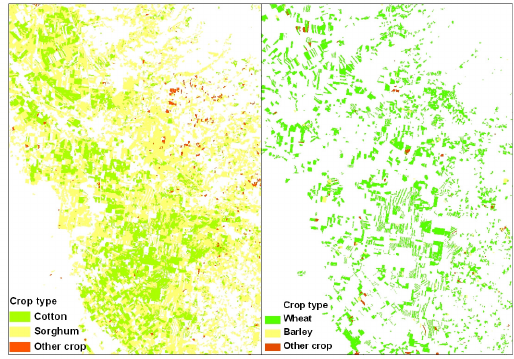
Figure 6. Classification of broad acre crop types for summer